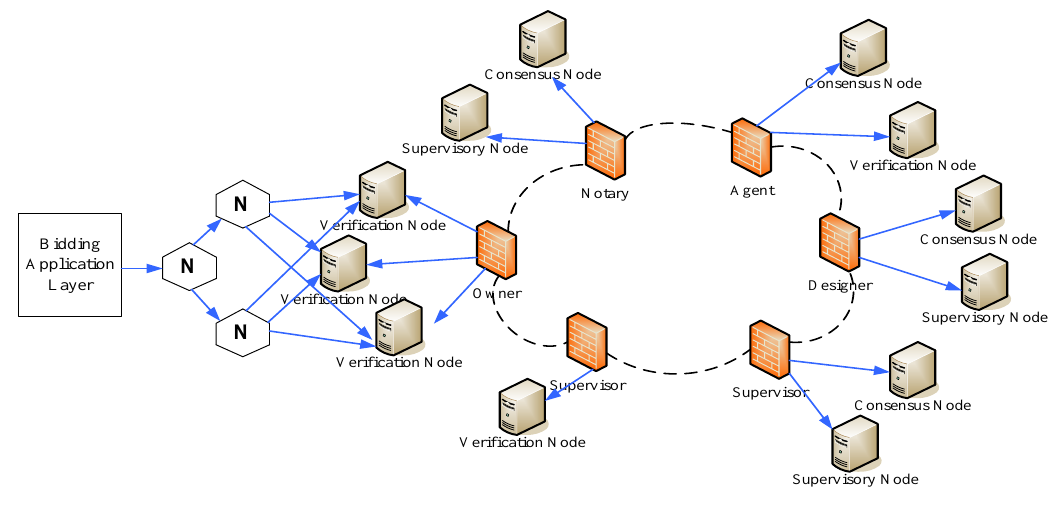
Figure 2. The relationship between nodes on the blockchain system. Table 4. The description of nodes. Types of